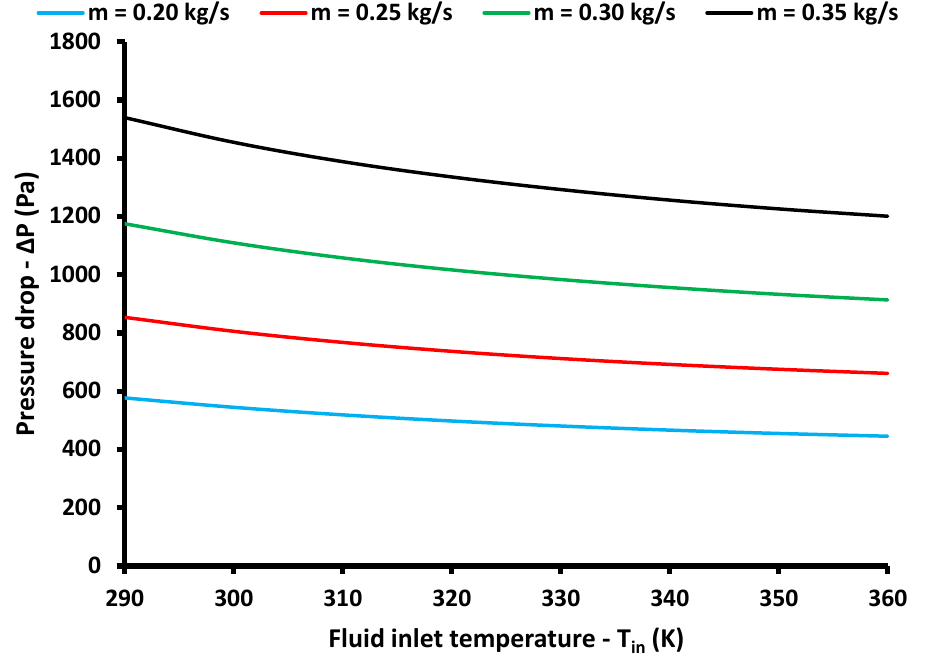
Figure 10. Pressure drop variation for the different operating scenarios in the reference case of the empty tube.